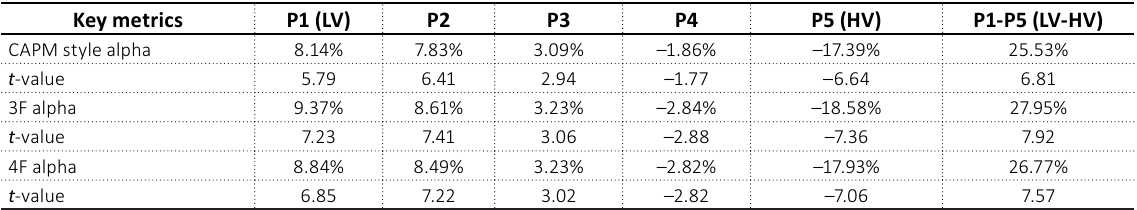
Table 2. C APM style alpha, three-factor alpha and four-factor alpha of volatility ranked portfolios Key metrics